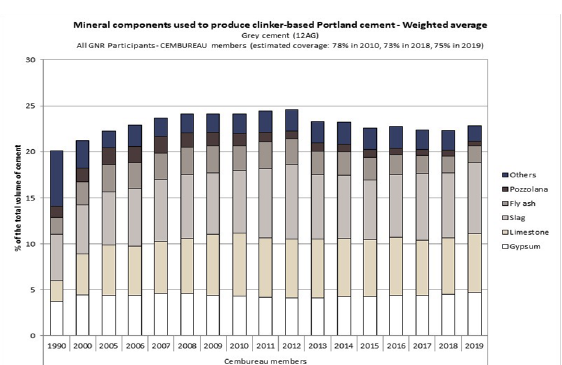
Figure 3. Evolution of clinker substitutes in Europe from GCCA, “getting the numbers right” database [38] readers are referred to the GNR web site in reference for more